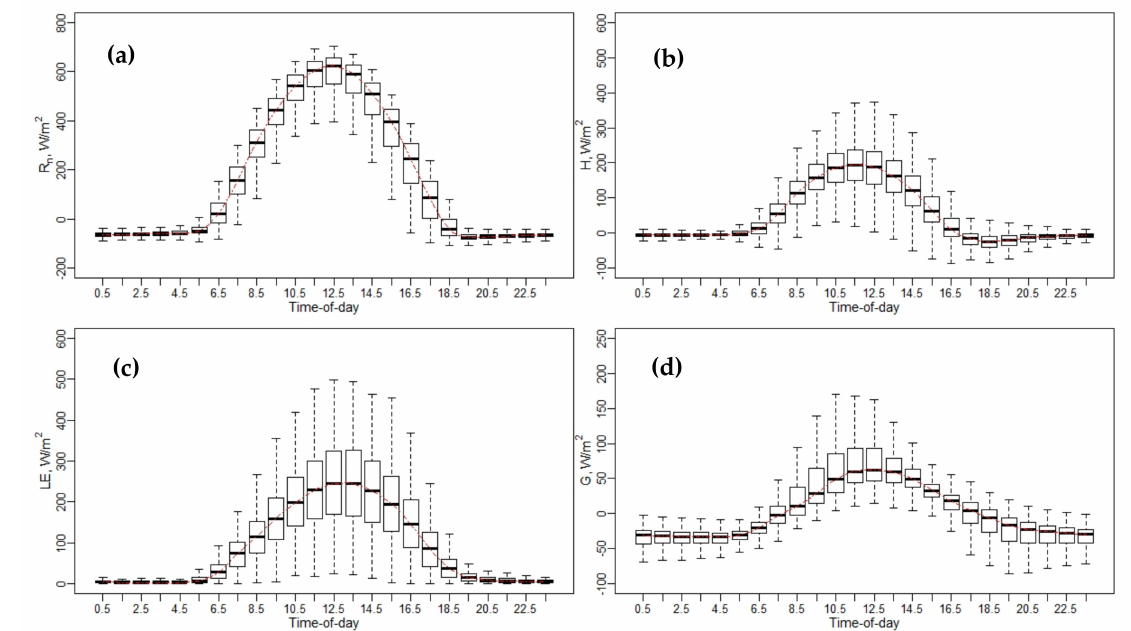
Figure 4. Diurnal variations of energy fluxes at Sierra Loma Sites 1 and 2 for the years 2014 to 2018, from the April to October irrigation season. ( a ) Net radiation ( R n ), ( b ) sensible heat flux ( H ), ( c ) latent heat flux ( LE ), ( d ) soil heat flux ( G